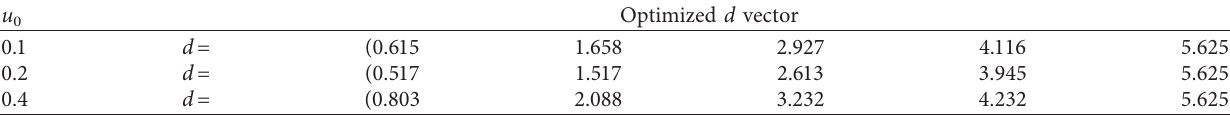
Table 1: Maximum solutions in BSO, 2 N � 10, normalized to 0.4 λ .